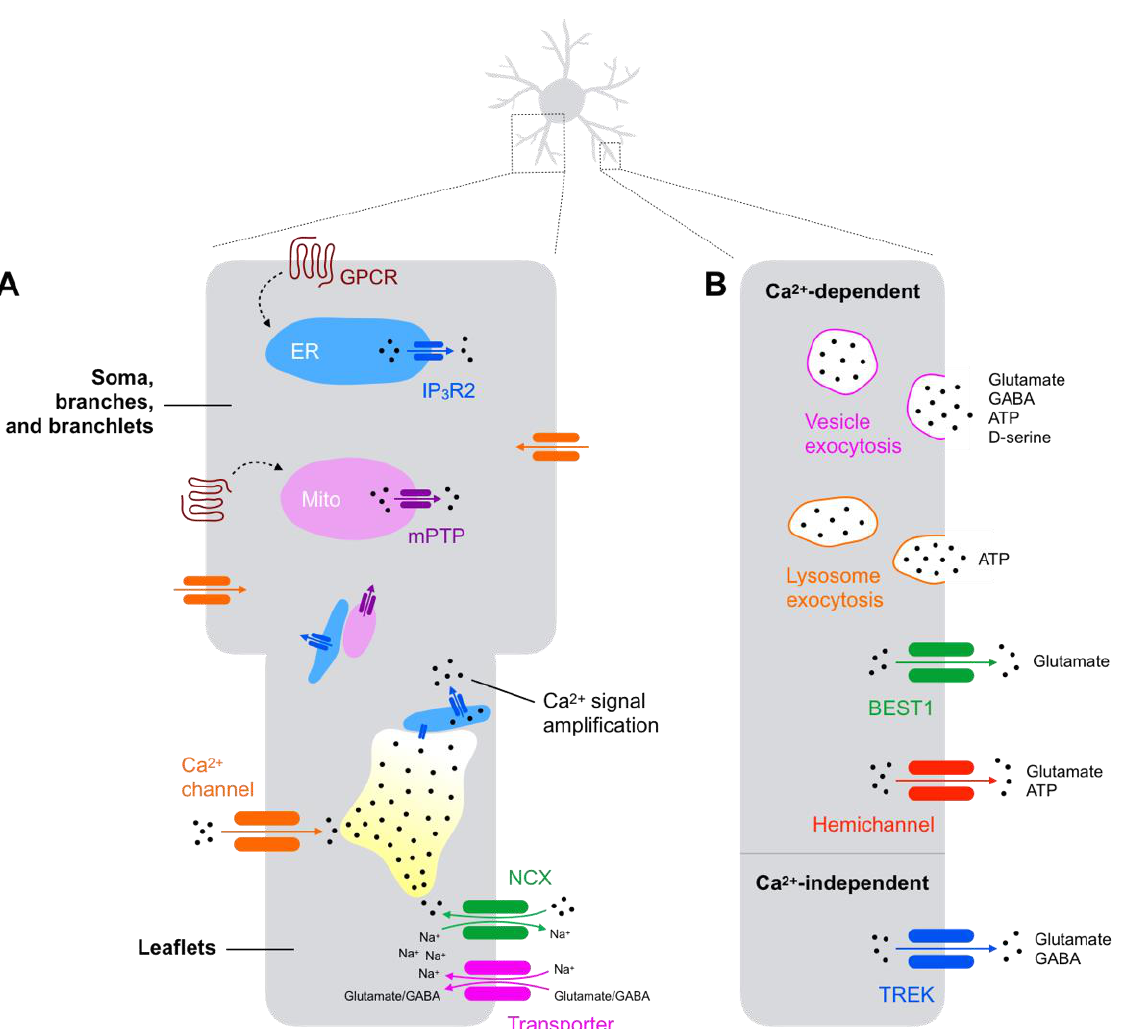
Figure 1. Mechanisms underlying intracellular Ca 2+ rises and gliotransmitter release from astrocytes. ( A ) At the soma, branches and branchlets of astrocytes, the activation of G-protein-coupled receptors (GPCRs) following increased synaptic activity triggers cytosolic Ca 2+ rises by several mechanisms, such as via the 1,4,5-trisphosphate receptor type 2 receptor (IP 3 R2)-dependent mobilization Ca 2+ from the endoplasmic reticulum (ER) or the efflux of Ca 2+ through mitochondrial membrane permeability transition pores (mPTPs). At fine processes of astrocytes, i.e., leaflets, increased synaptic activity may promote the co-transport of neurotransmitters and Na + into the cytosol, the latter increasing the activity of Na + /Ca 2+ exchangers (NCX) that results in cytosolic Ca 2+ elevations. Additionally, Ca 2+ -permeating channels contribute to the influx of Ca 2+ in astrocytic leaflets. The Ca 2+ influx into leaflets may trigger local Ca 2+ transients and propagate the Ca 2+ signaling to distant domains via its signal amplification mediated by a Ca 2+ -dependent Ca 2+ release from ERs via the IP 3 R2 pathway; ( B ) Several mechanisms account for the release of gliotransmitters from astrocytes. Mostly, these processes occur in a Ca 2+ -dependent manner via the exocytosis of vesicles. Lysosome exocytosis, bestrophin1 (BEST1) channels and hemichannels have also been described to participate in Ca 2+ -dependent gliotransmitter release mechanisms. Moreover, the involvement of a Ca 2+ -independent release of gliotransmitters via two-pore domain K + (TREK) channels is reported.